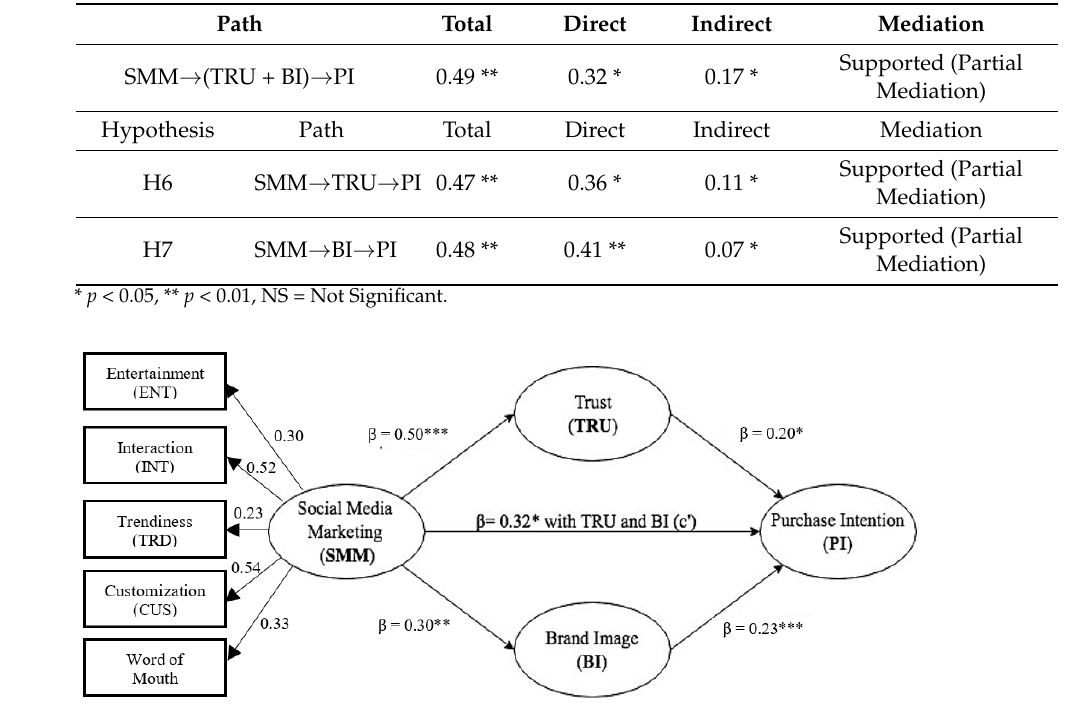
Figure 2. The SEM result with TRU and BI as mediation variables.